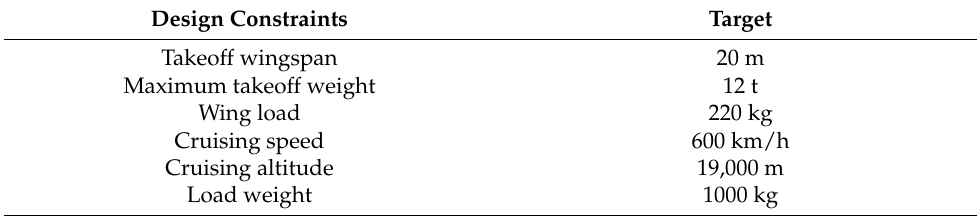
Figure 13. Three aircraft configurations involved in the comparison. Table 1. Design constraints of the high-altitude UAV.